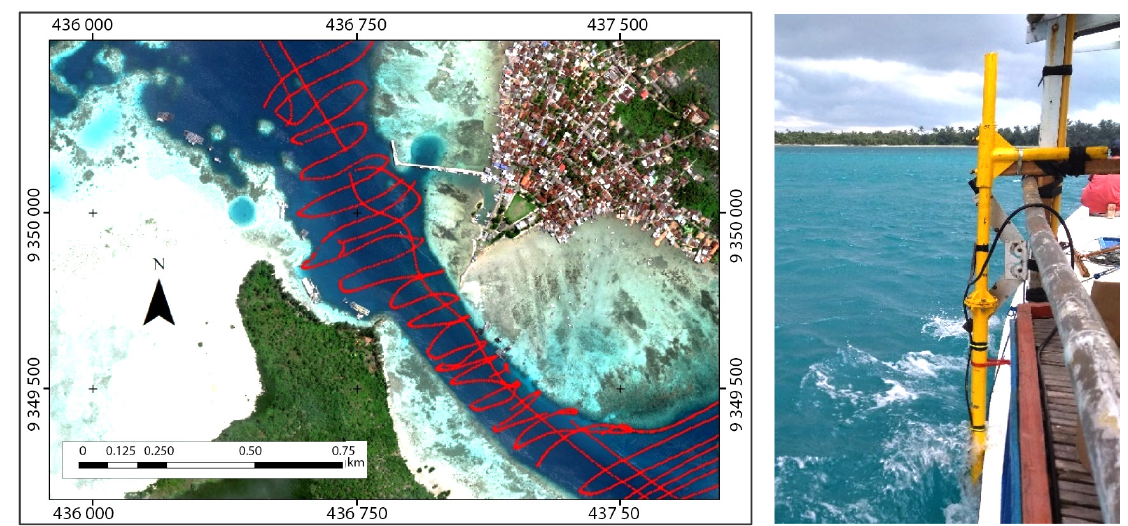
Figure 3. In-situ bathymetric points (left, represented in red) in the study